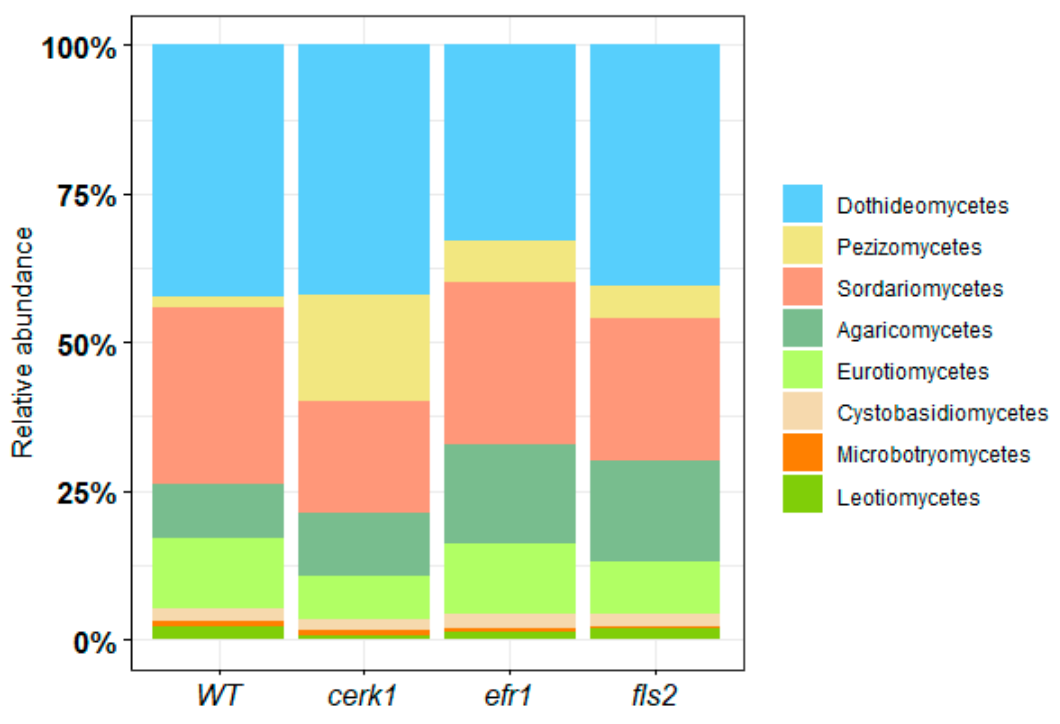
Figure 3. Relative abundance of the most represented enriched fungal class from the rhizosphere of Arabidopsis PAMP mutants ( cerk1 , efr1 , and fls2 ) and the wild-type (WT; Col-0) grown in native soil from the Red River Farm (OK, USA). Fungal classes that were <1% abundant were not included. 2.2. The Pezizaceae Family Is Highly Enriched in the cerk1 Mutant and All